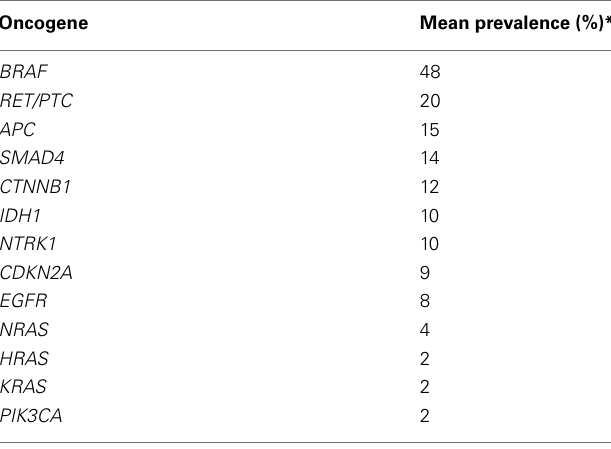
Table 1 | Different prevalences of different oncogenes reported to be involved in thyroid